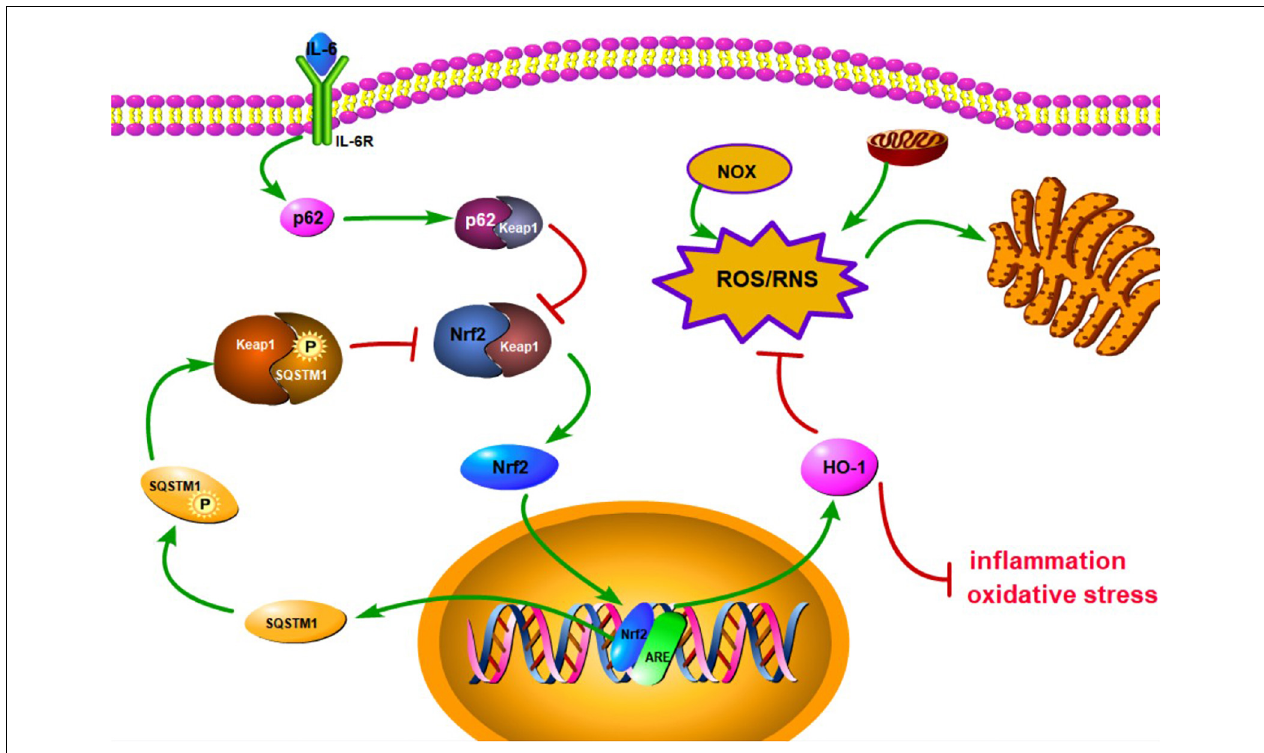
FIGURE 1 | Schematic diagram of the activation of antioxidant stress signal pathway, Keap1/Nrf2/HO-1. IL-6 can bind to membrane surface receptors and activate p62 to bind to Keap1, thereby inhibiting the binding of Keap1 to Nrf2. Subsequently, keap1-Nrf2 complex releases Nrf2 to enter the nucleus and promote the expression of HO-1 and SQSTM1. HO-1 can inhibit inflammation and oxidative stress, and reduce endoplasmic reticulum stress by inhibiting ROS/RNS pathway. SQSTM1 can inhibit keap1-Nrf2 complex to result in releasing Nrf2 and form a positive feedback.